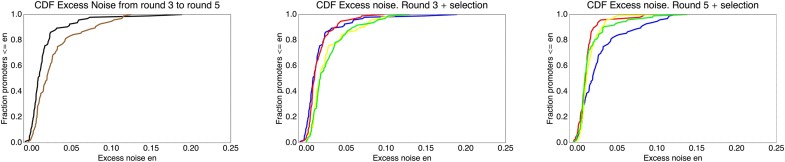
Cumulative distribution functions of excess noise levels for the promoters extracted from different populations.Left panel: Excess noise levels of promoters from the third (black) and fifth (brown) round of the evolutionary run. Middle panel: Excess noise levels of promoters from the third round of the evolutionary run (blue), and from clones that resulted from another round of either stringent (red), normal (yellow), or weak (green) selection. Right panel: As in the middle panel but now for clones from the fifth round and clones resulting from another round of selection on this population.